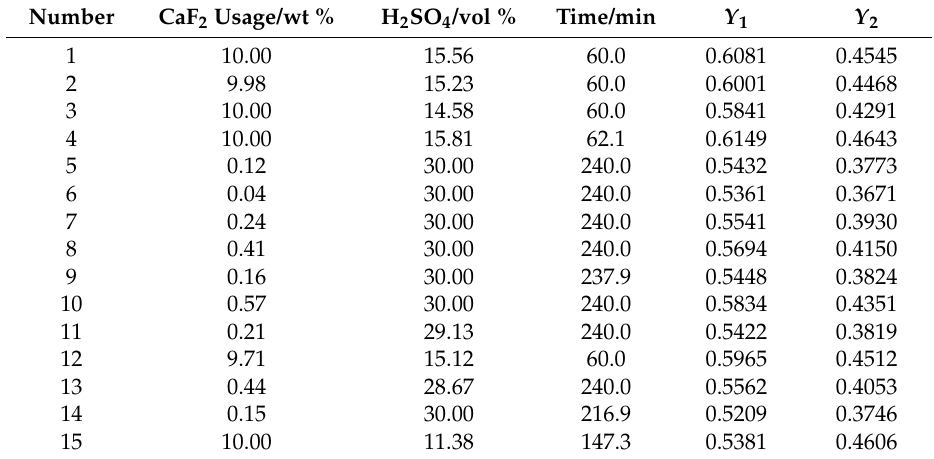
Figure 3. 3D response surface plot of the interactive effects between CaF 2 and H 2 SO 4 concentration on V leaching efficiency in MH. Table 6. Solutions given out at target of V leaching efficiency in MH at Maximize and Minimize in CH.